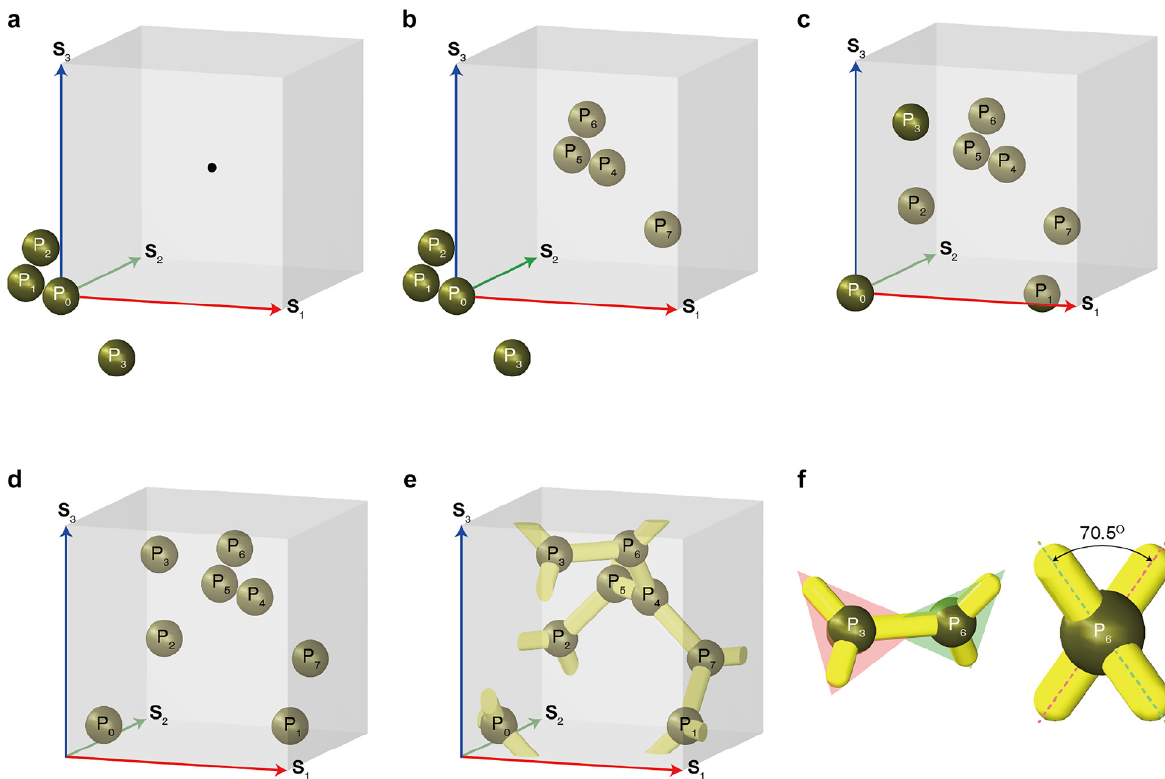
Figure 1: Building a ball-stick gyroid. (a) A BCC lattice and a basis comprising four balls. (b) Additional basis copied from origin to center of cube. (c) Balls only in given cube after